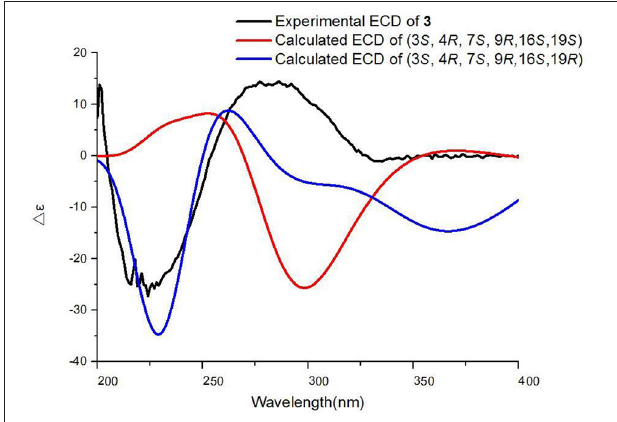
FIGURE 3 | Experimental and calculated ECD spectra of compound 3